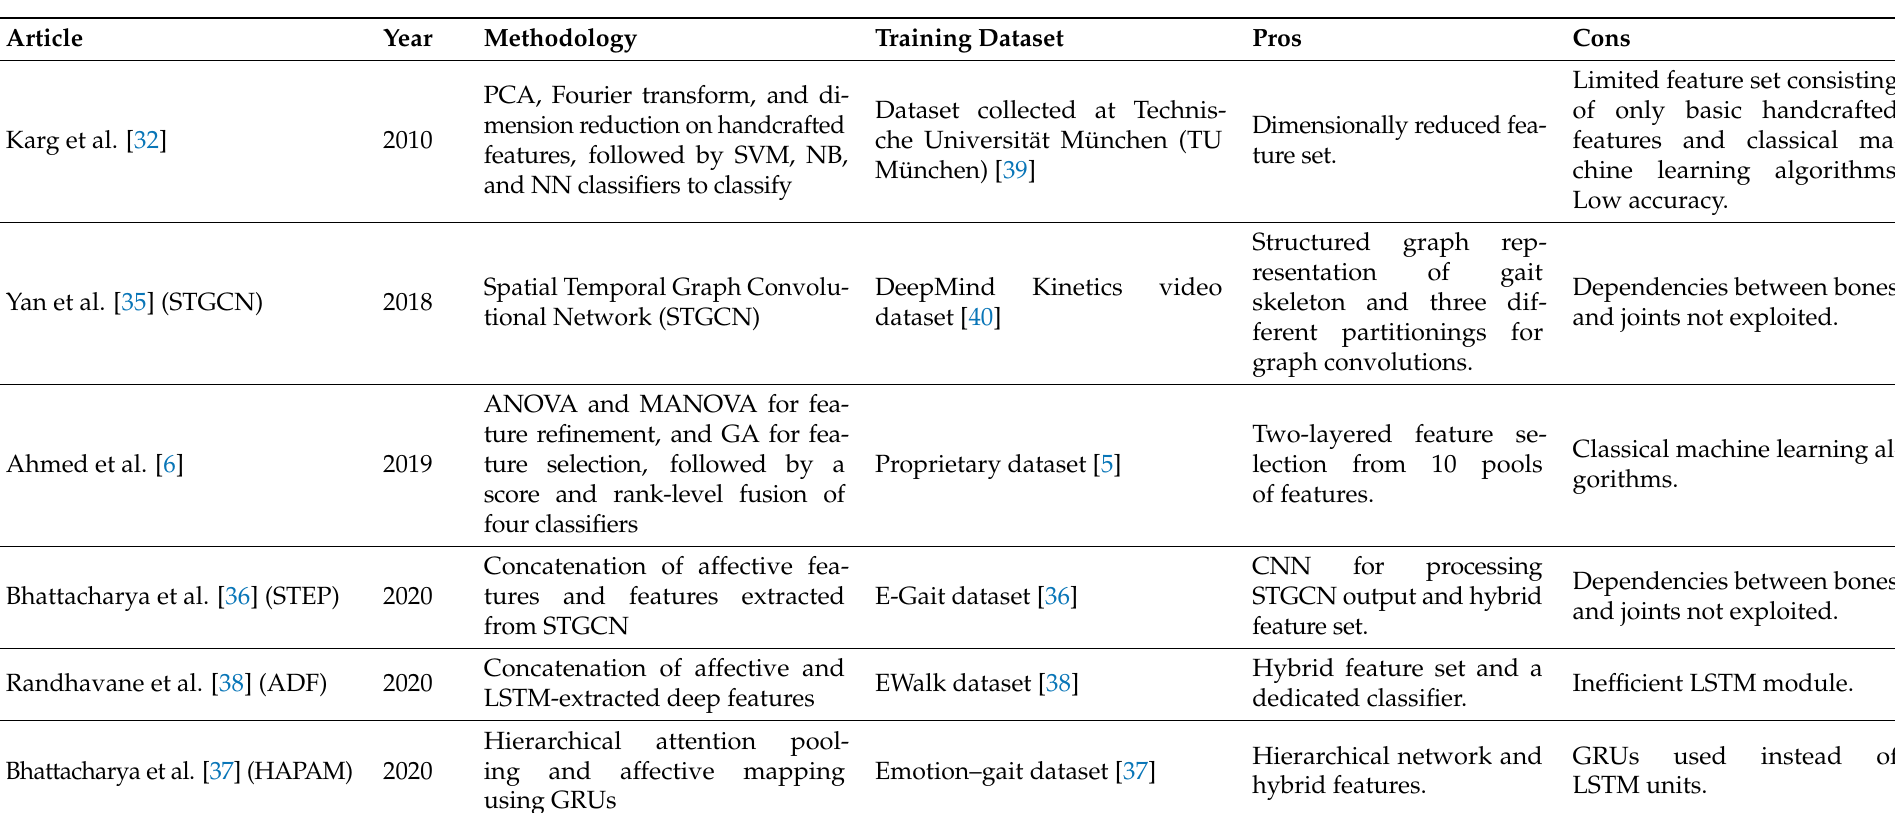
Table 1. Summary of gait emotion recognition